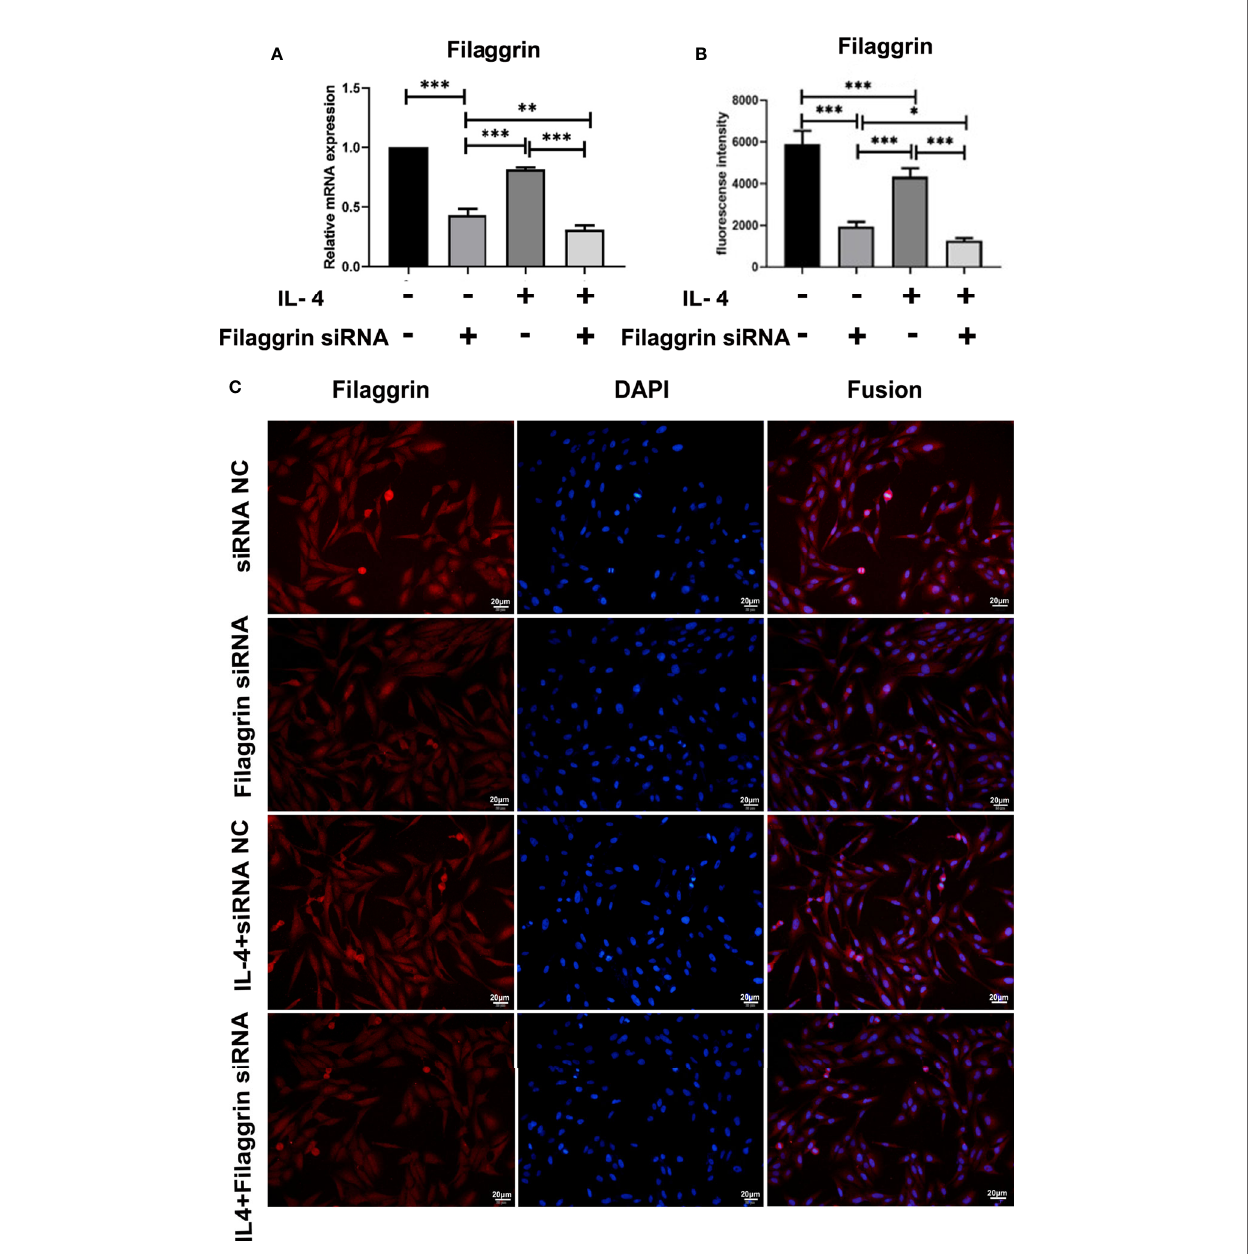
FIGURE 7 | Filaggrin was more signi fi cantly decreased by IL-4 treatment after knock-down of fi laggrin with speci fi c siRNA. BEAS-2B cells were divided into four groups: siRNA NC group (control group), fi laggrin siRNA group, IL-4 inducted group and fi laggrin siRNA + IL-4 inducted group. (A) The mRNA expression of fi laggrin among the four groups detected with RT-PCR. (B, C) The protein levels of fi laggrin in the four groups were detected with IF. The photographs were magni fi ed of 400 times and the bars represented 20 m m. Each experiment has been repeated for 3 times and presented as the mean ± SD (n=3). The Student ’ s t-test was used to analyze the difference between groups. *P < 0.05 was considered as statistically signi fi cant. **P < 0.01, ***P <